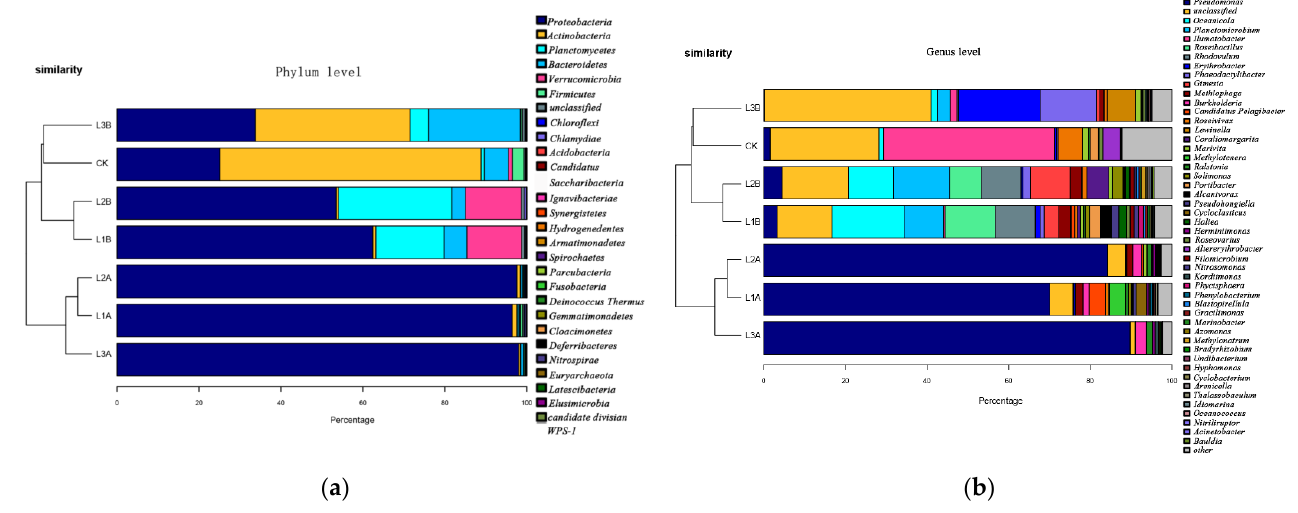
Figure 4. Effects of C. vulgaris LH-1 supplementation on bacterial community in seawater with 0.01 g/L crude oil and different nutrient concentrations. ( a ) Phylum Level. ( b ) Genus Level.